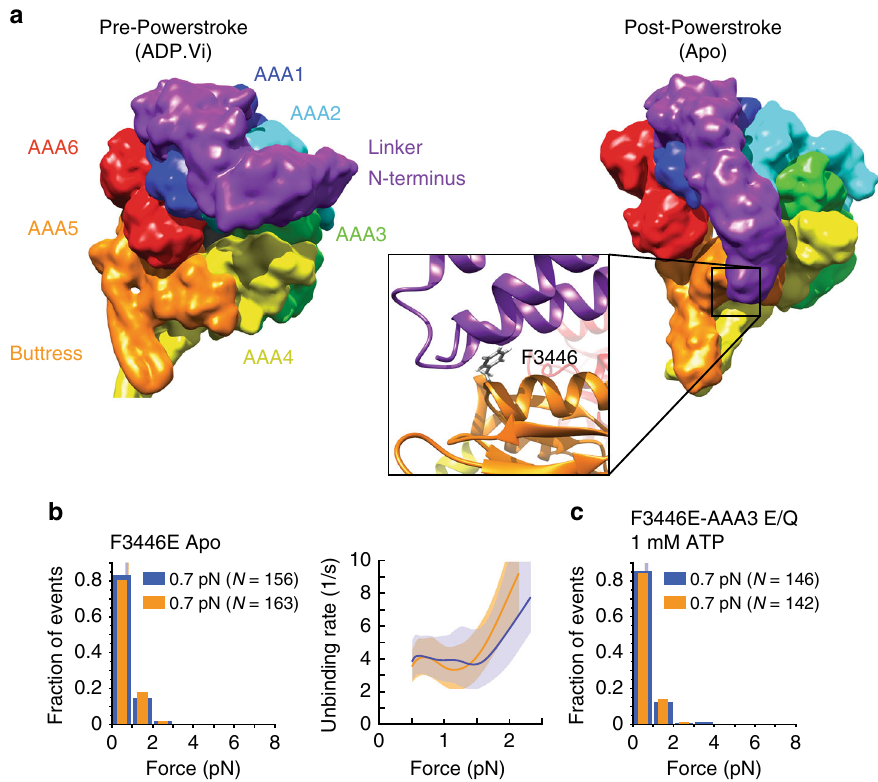
Fig. 6 Docking/undocking of the linker to and from AAA5 controls tension-induced recon fi guration of the stalk. a Structures of the dynein MD in the pre- powerstroke (ADP.Vi, Homo sapiens cytoplasmic dynein-2; PDB entry 4RH7 47 ) and post-powerstroke (Apo, S. cerevisiae dynein; PDB entry 4W8F 13 ) states. In the pre-powerstroke state, the linker is bent and close to AAA2 (left), while in the post-powerstroke state, the linker is straight and docked on AAA5 (right). (inset) Interactions between hydrophobic residues of the linker and the highly conserved F3446 of AAA5 facilitate the docking of the linker N- terminus on AAA5 13 (PDB entry 4W8F 23 ). b , left: Normalized histograms of primary forward and backward unbinding forces for the F3446E-Dyn1 331kDa mutant, with mean values noted (95% CIs [0.7, 0.8] and [0.7, 0.8] pN, estimated by bootstrapping 4000 samples). b , right: Unbinding rate vs. force derived from the data on the left. The shaded areas are 95% CIs for the mean rates, estimated by bootstrapping. c As in b , but for the F3446E-AAA3 E/Q Dyn1 331kDa CT-GFP mutant and 1 mM ATP (95% CIs [0.6, 0.8] and [0.6, 0,7] pN). Source data are provided as a Source Data fi